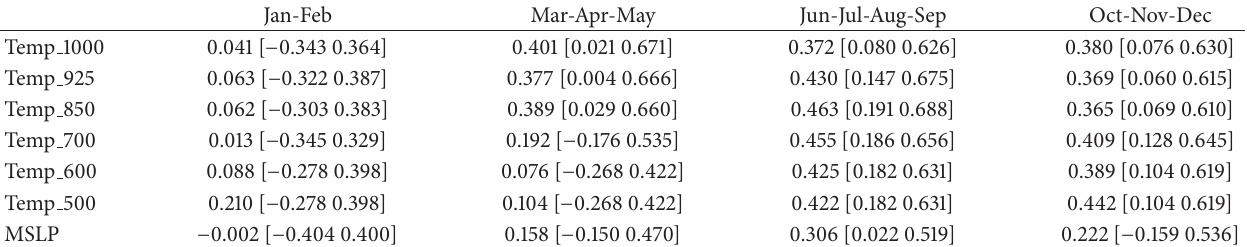
Table 10: Actual correlation and Bootstrapping results of correlation at 95% confidence intervals.